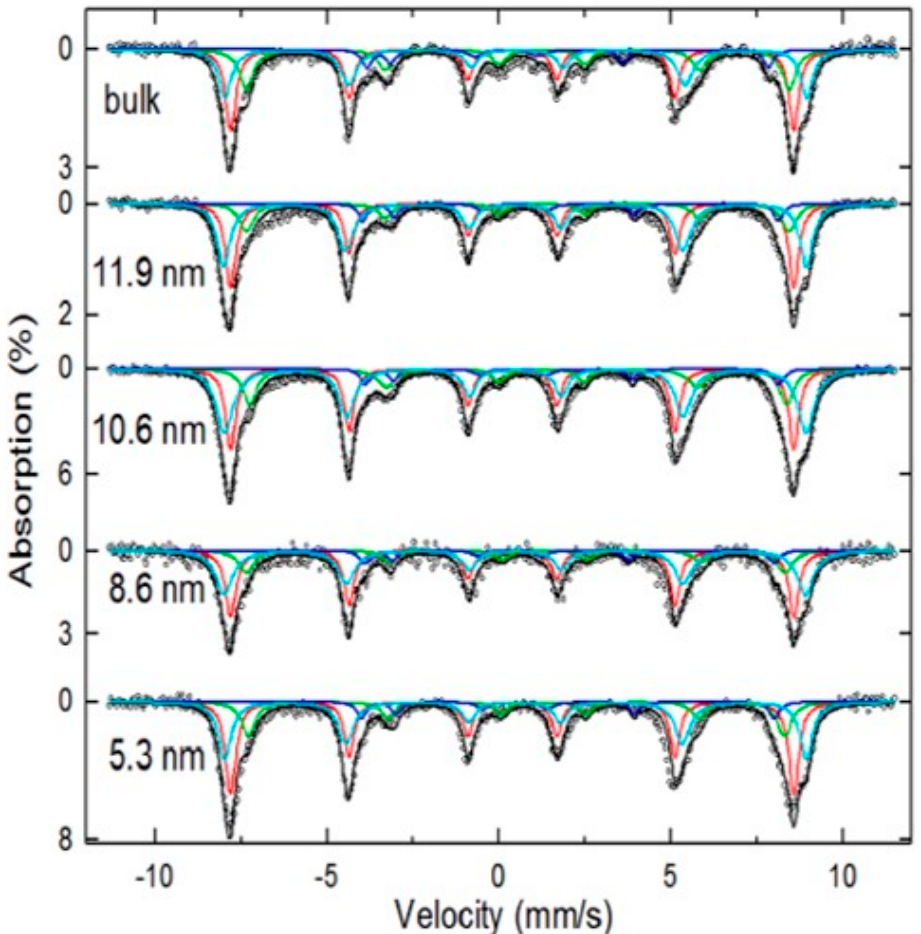
Figure 3. Mössbauer spectra of Fe 3 O 4 at 6 K of bulk and 11.9 nm, 10.6 nm, 8.6 nm, and 5.3 nm particles. Fitted spectra are (red) tetrahedral Fe(III), (light blue) octahedral Fe(III), (green and dark blue) octahedral Fe(II). (Reproduced with permission of Elsevier [7].)